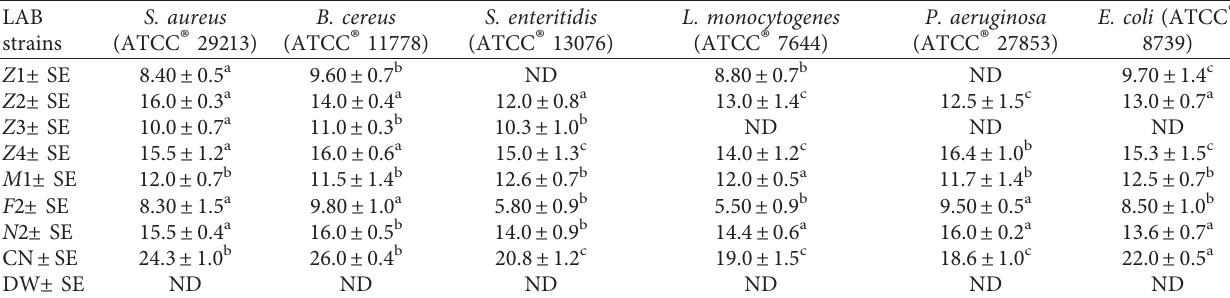
Table 6: The antibacterial activity of the seven CFS LAB strains against food spoilage and pathogenic bacterial strains using the disc diffusion assay. LAB